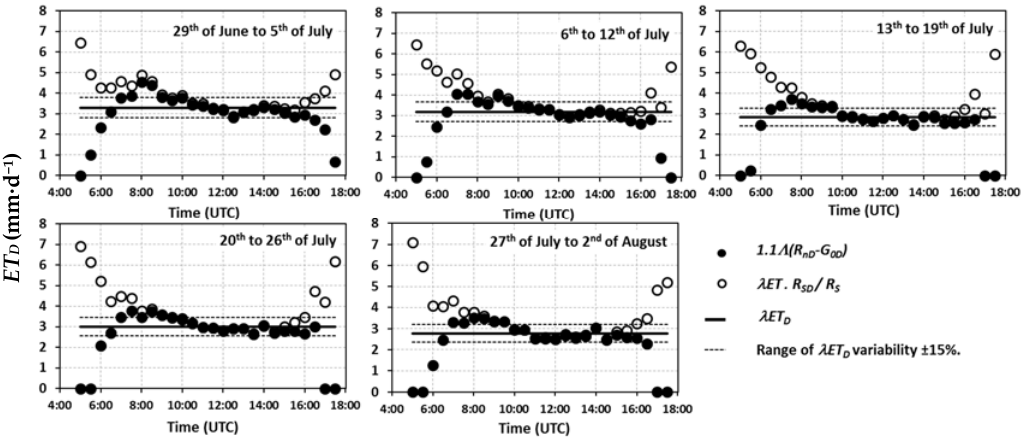
Figure 8. The weekly 30 min averaged diurnal changes of (black dots) and (empty dots) with the ET D measured with EC tower and the range of variability ±15%.